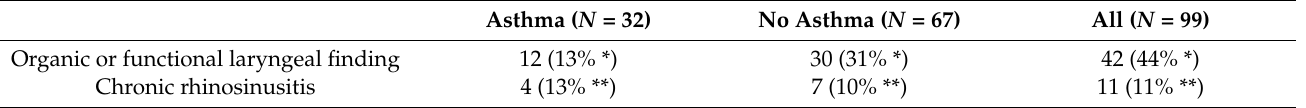
Table 1. Laryngeal and chronic rhinosinusitis findings in patients grouped by asthma diagnosis. Asthma ( N = 32)